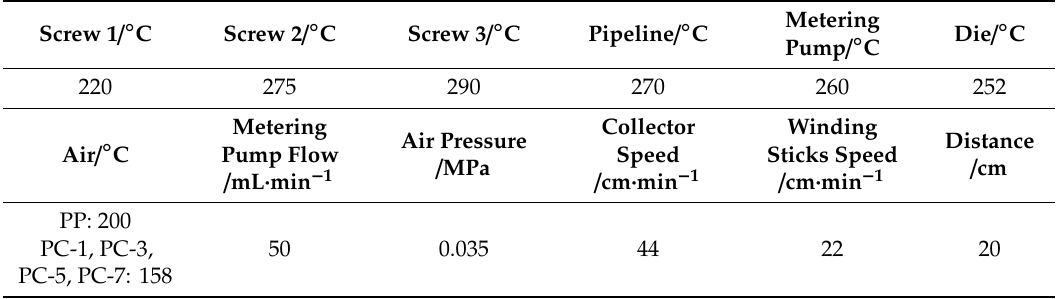
Table 2. Processing conditions of meltblown